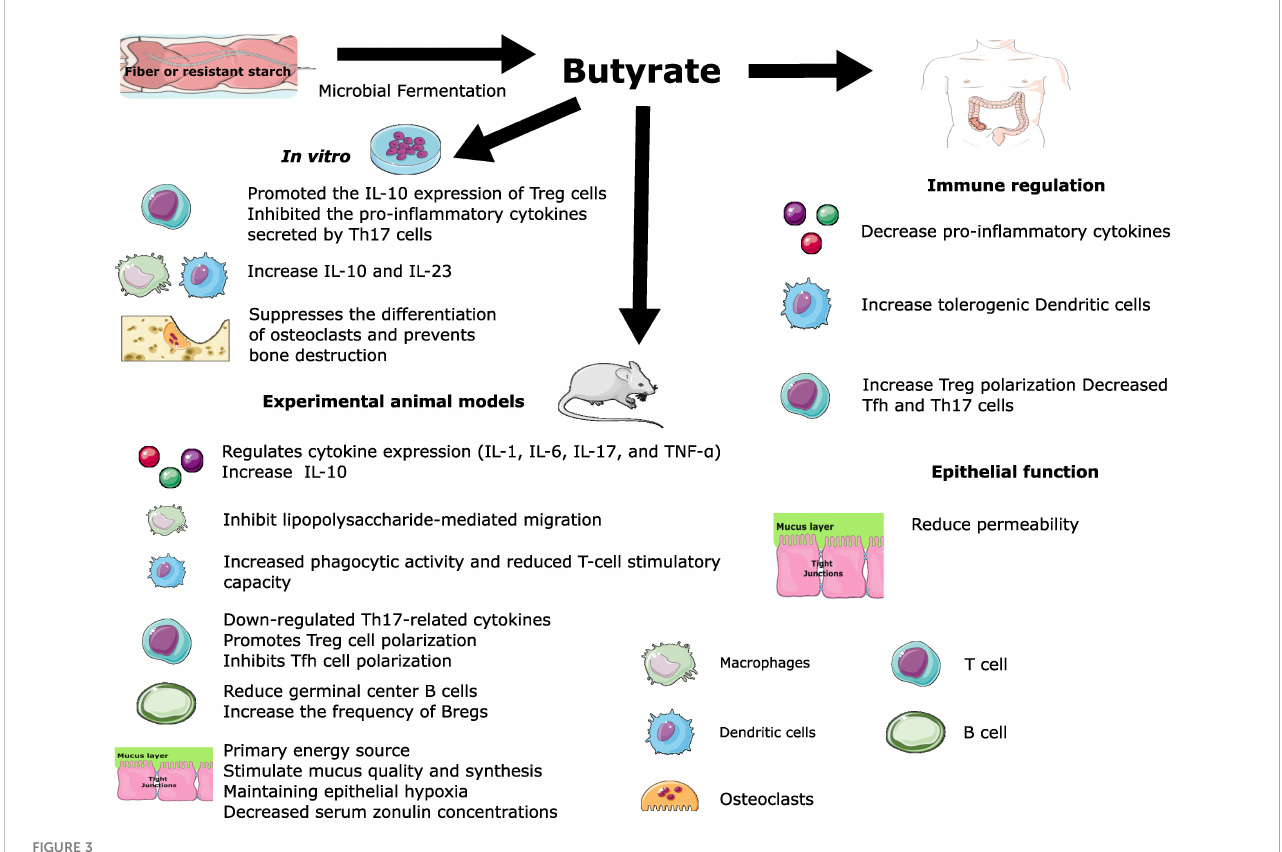
FIGURE 3 Pleiotropic immunomodulatory effect of